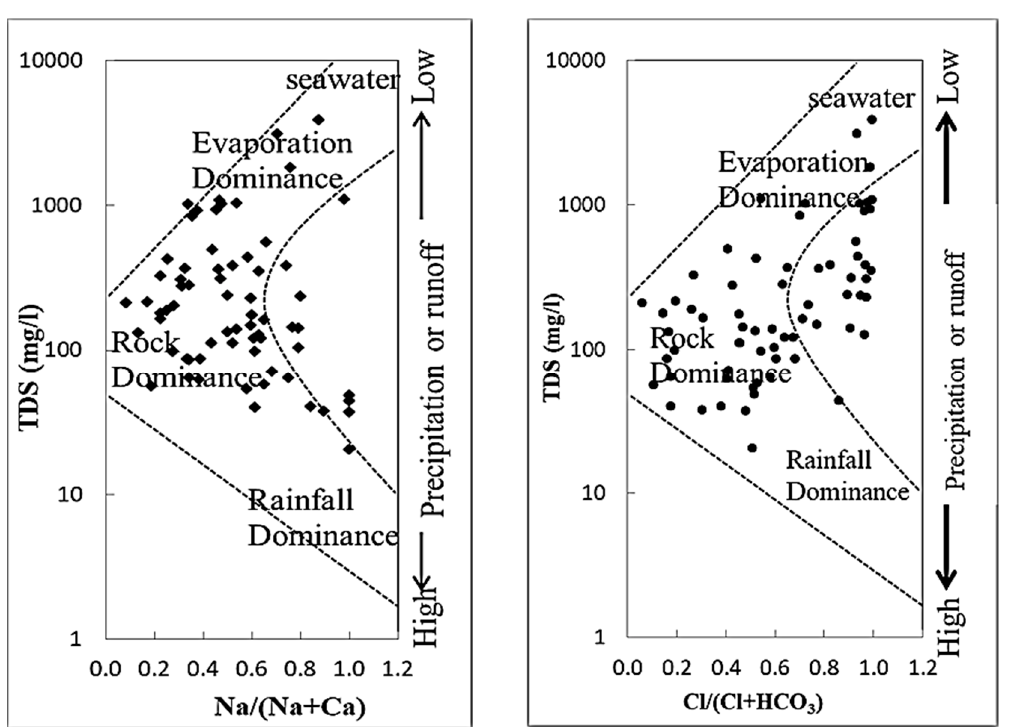
Figure 6. Mechanism controlling groundwater chemistry.